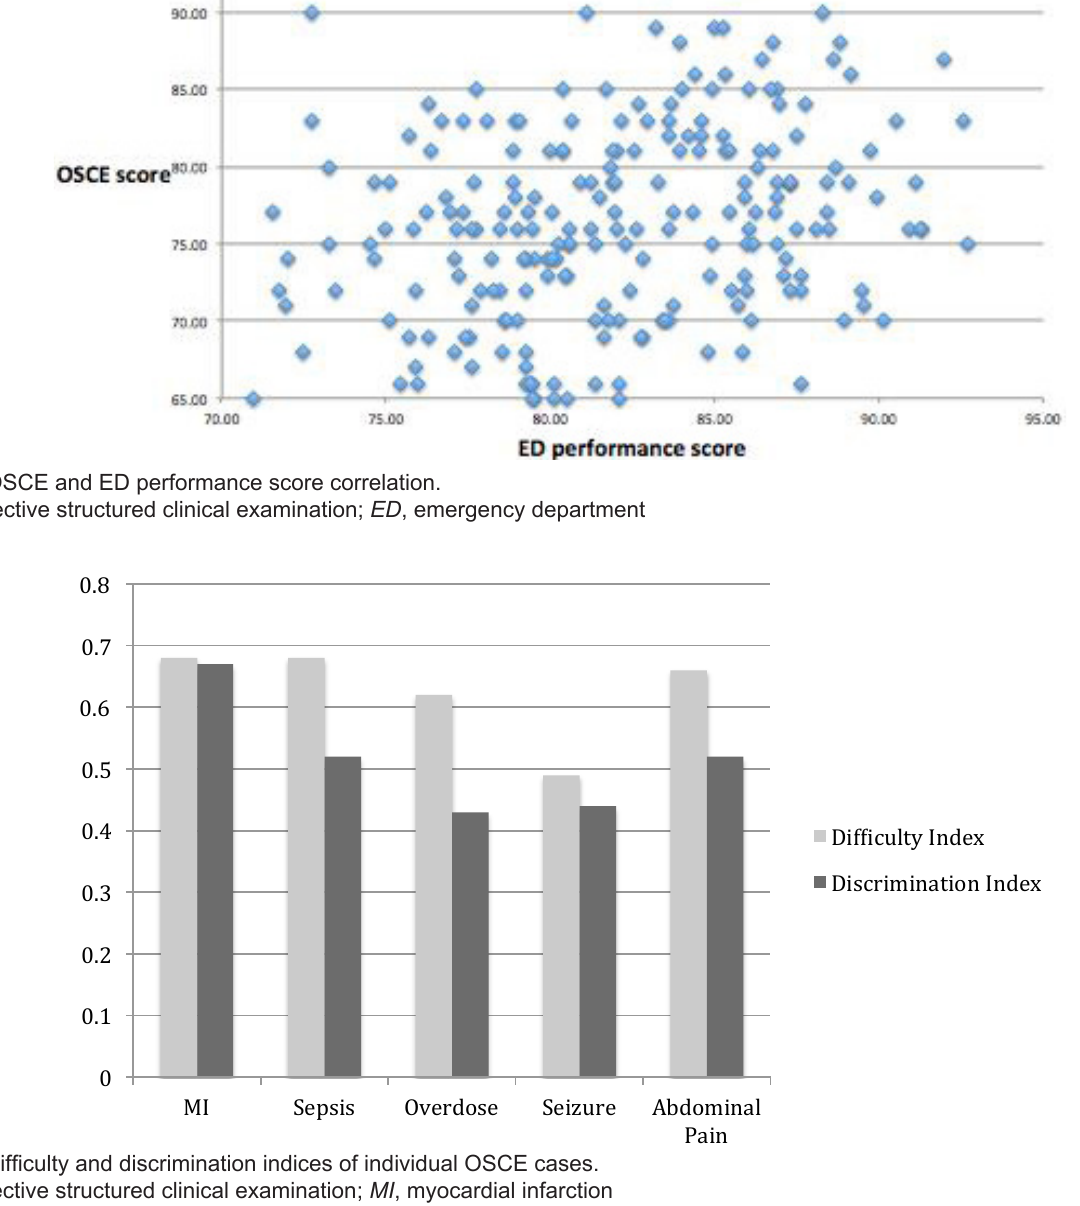
Figure 3. Difficulty and discrimination indices of individual OSCE cases. OSCE , objective structured clinical examination; MI , myocardial infarction